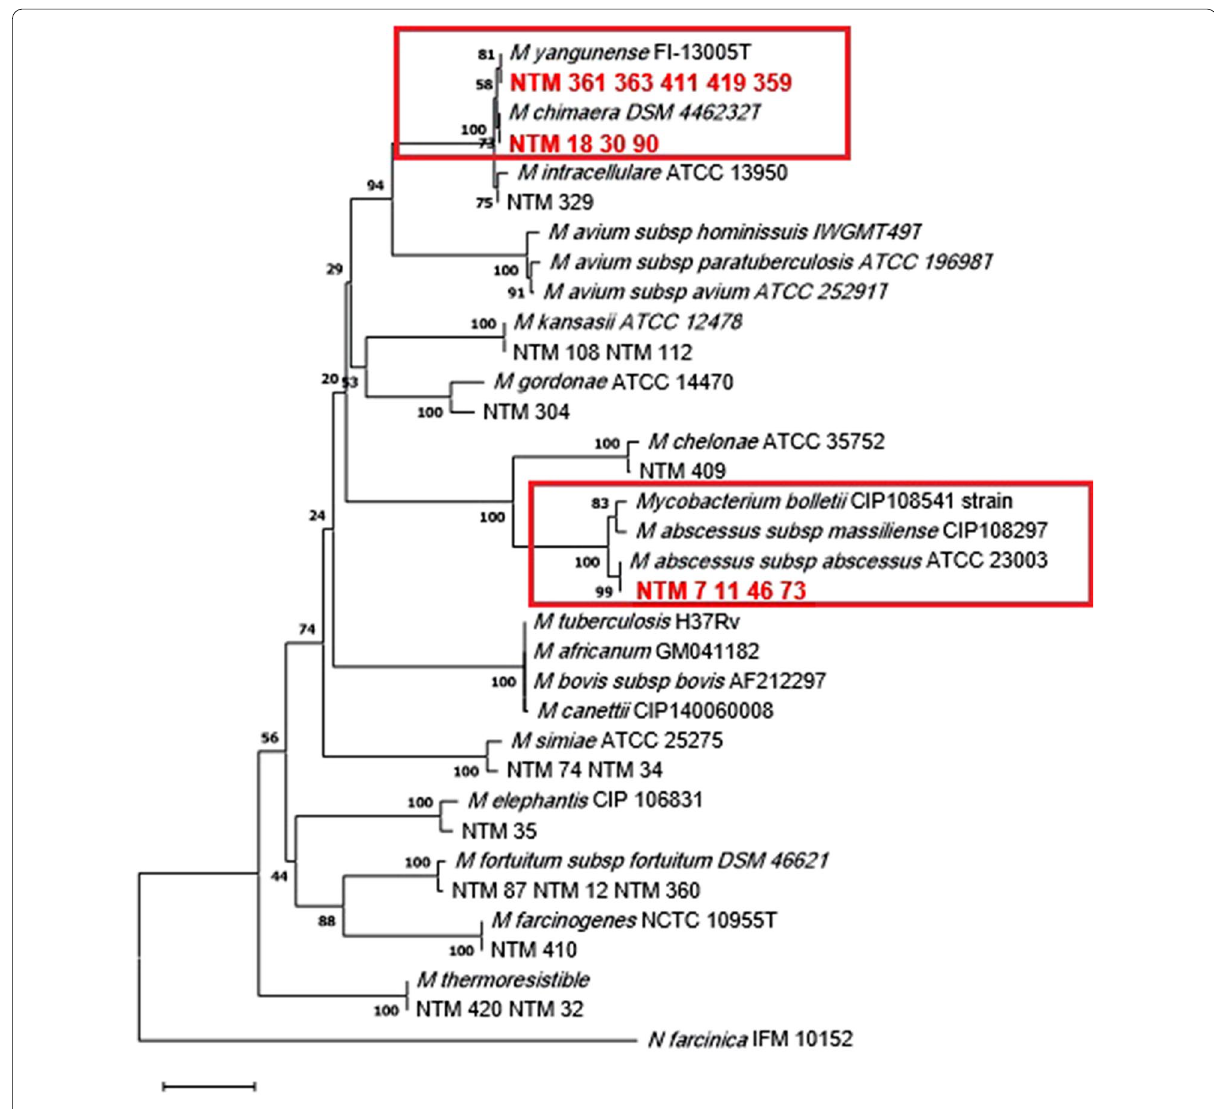
Fig. 2 Phylogenetic relationship (evolutionary tree) of clinical isolates of nontuberculous Mycobacteria based on argH gene sequencing (the maximum likelihood tree generated using the Tamura 3-parameter model in MEGA11 software). Boxes are represented of isolates that could be identified by argH